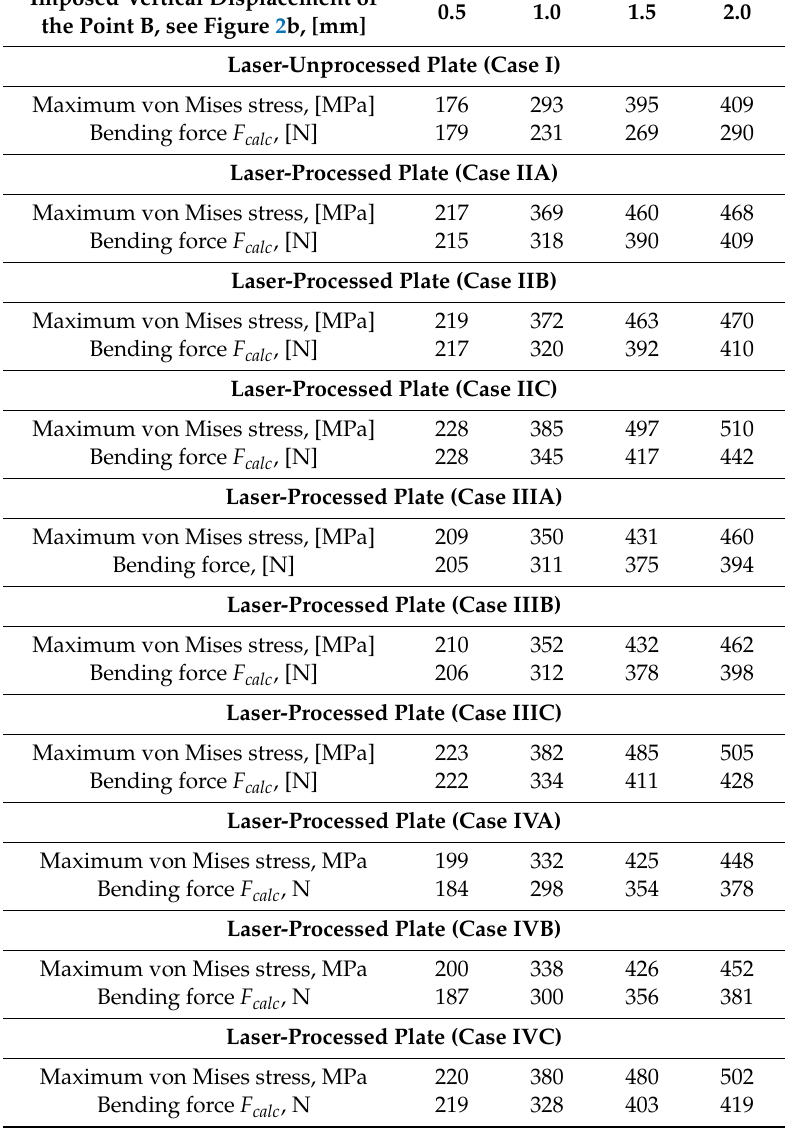
Table 9. The maximum Von Mises equivalent stresses (in MPa), and corresponding forces F calc (in N) of the finite element analysis (FEA) simulation of the bending of the di ff erently laser-processed plates